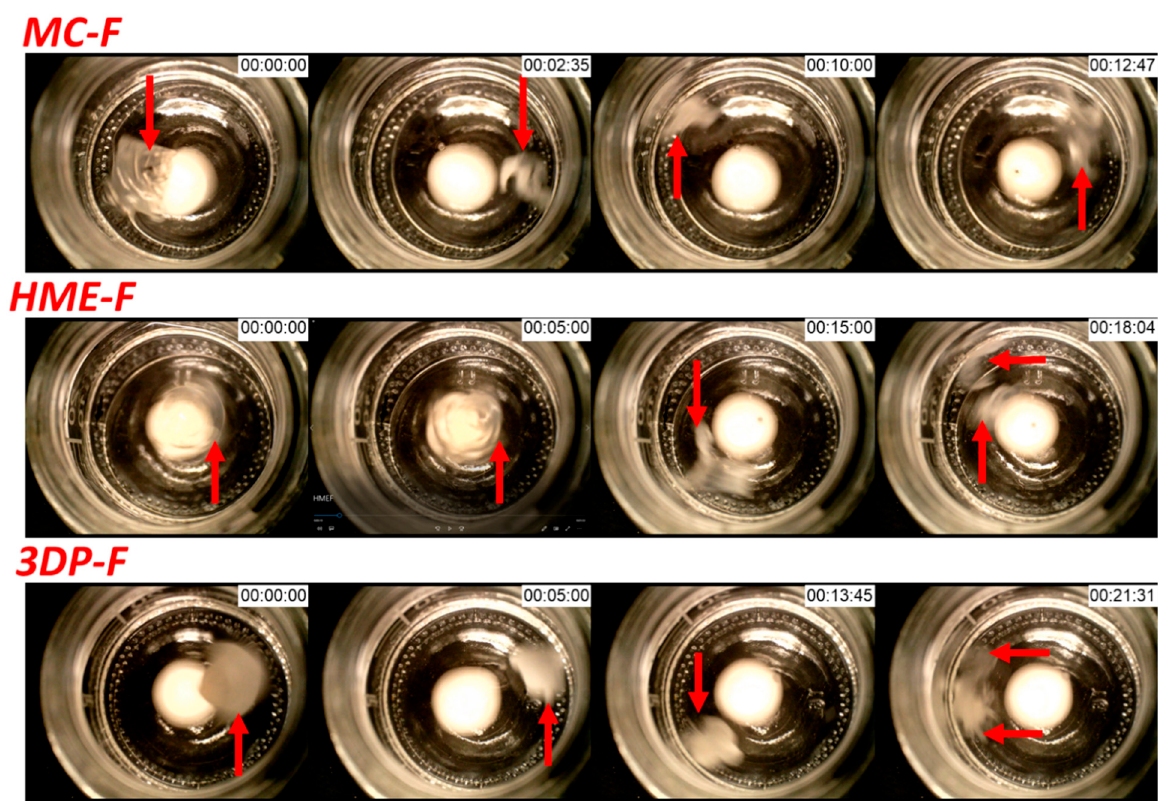
Figure 11. Demonstration of the modified disintegration studies for MC-F, HME-F, and